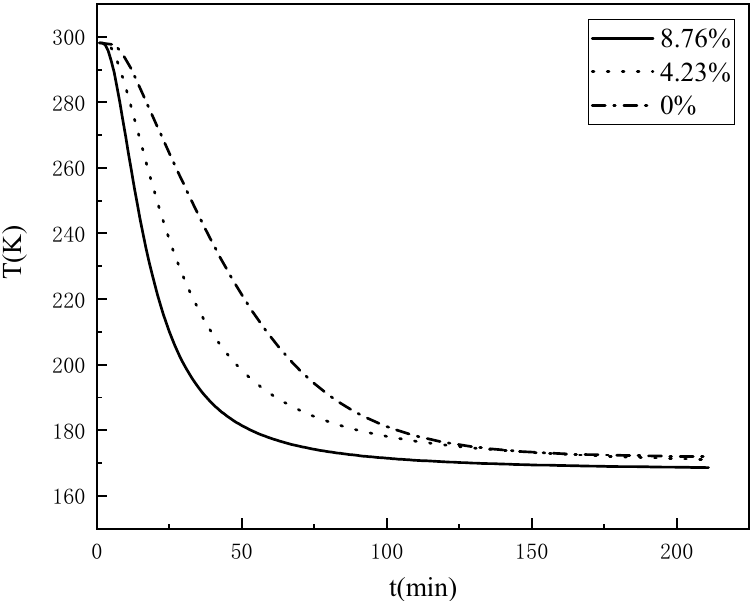
Figure 5. The law of temperature change under different water content conditions (60 mm).